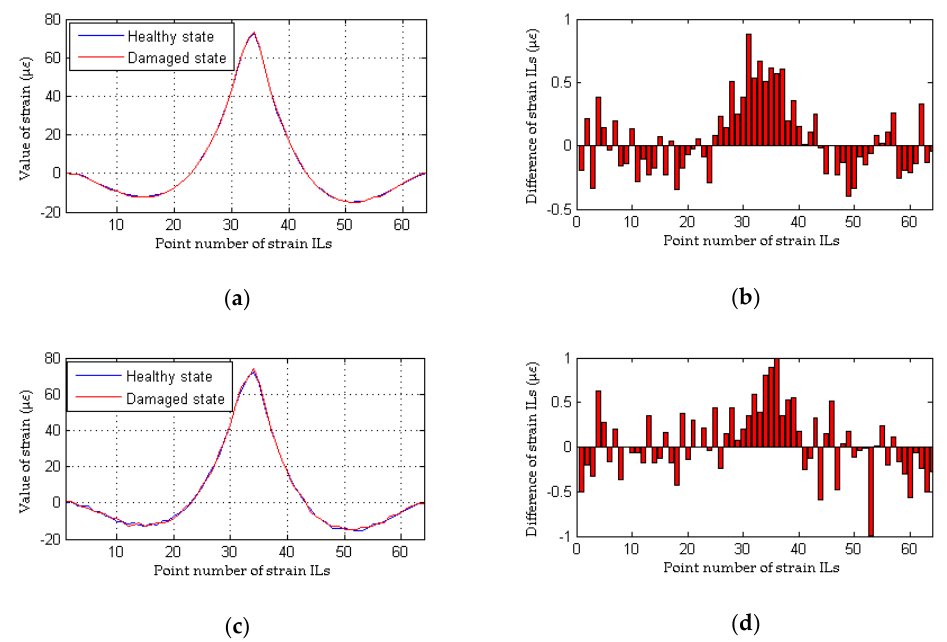
Figure 10. Results of the traditional method considering the effects of measurement noise (for multiple damaged elements): ( a ) strain ILs at point #31 for case 1 and case 6; ( b ) difference in the strain ILs at point #11 before and after damage for case 6; ( c ) strain ILs at point #31 for case 1 and case 7; ( d ) difference in the strain ILs at point #31 before and after damage for case 7.